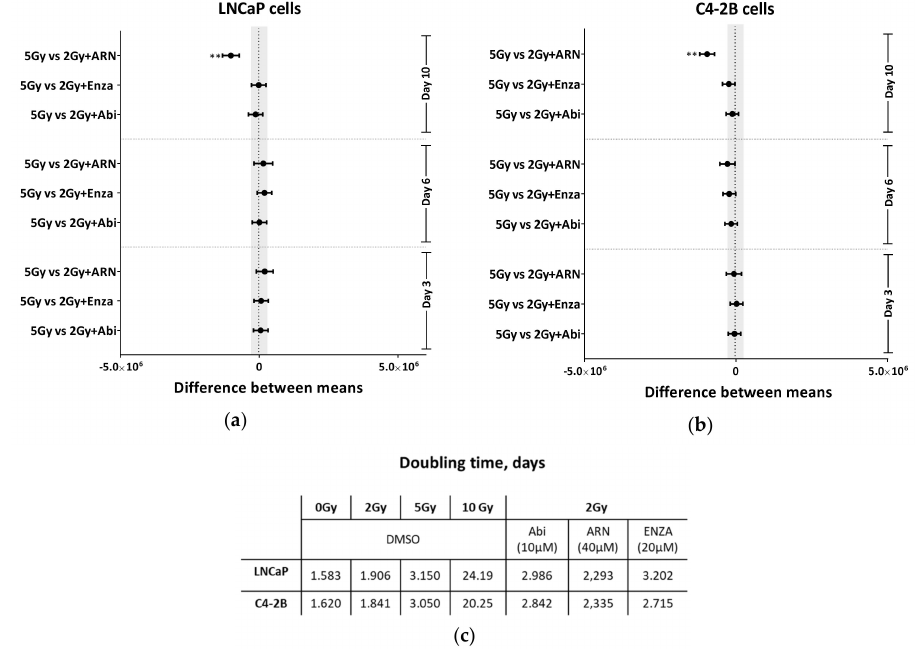
Figure 4. Second generation antiandrogen therapy enhances the IR e ff ect at least 2-fold. Tukey’s multiple comparisons test was used to compare between the e ff ect of 5 Gy and the di ff erent indicated treatments on the growth inhibition in ( a ) LNCaP and ( b ) C4-2B cells. Significance was measured using two-way ANOVA test. ( c ) Cell-doubling time in days was calculated for the indicated treatments by fitting exponential growth curves using GraphPad Prism 7. Shown are means ± SEM of at least three independent experiments. Significance is indicated as ** for p <